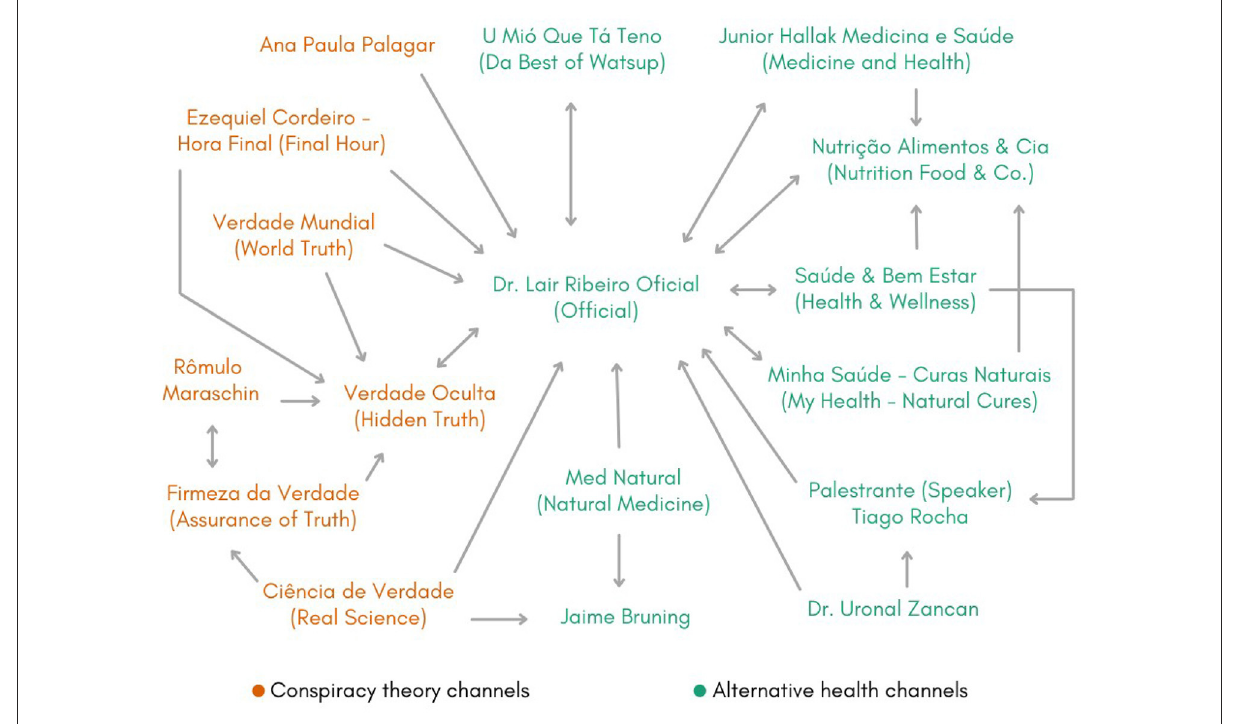
FIGURE5 Collaboration between conspiracy theory and alternative health